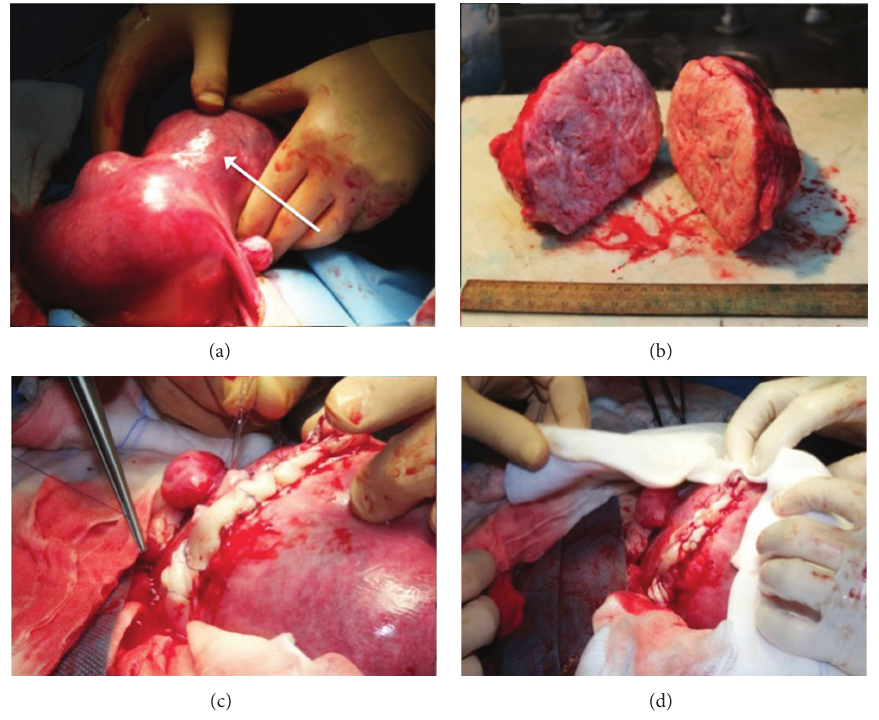
Figure 3: Myomectomy and uterine wall